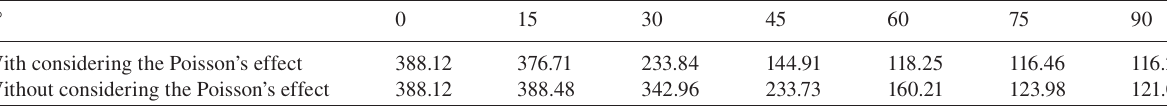
Table 3 Critical velocity (m/s) of angle-ply beams with and without considering the Poisson ’ s effect. θ °